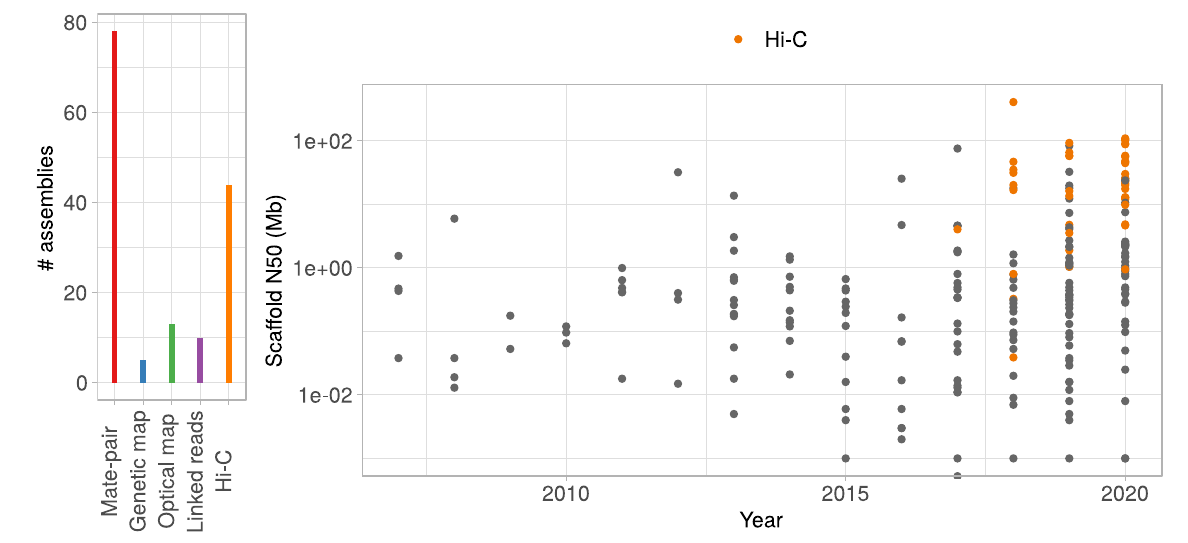
Figure 6 – Assemblies scaffolding. Left: number of assemblies that included each scaf- folding method. Right: scaffold N50 of non-vertebrate animal genome assemblies over time. The assemblies that included a Hi-C scaffolding step are highlighted in orange; they form a cluster with a scaffold N50 over 1